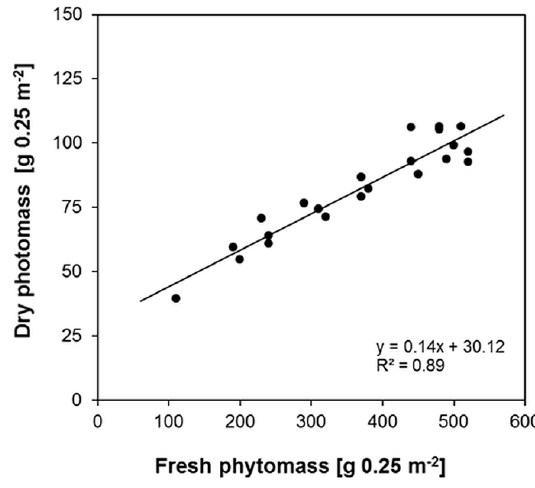
Figure 15. Relationship between fresh and dry phytomass of lucerne measured at the 22 permanent observation sites.